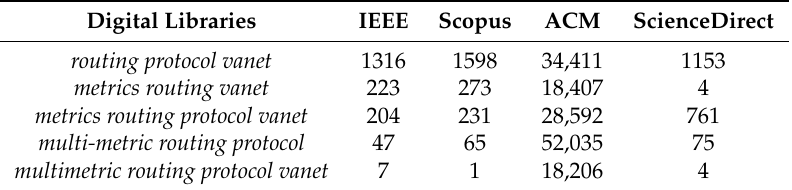
Table 1. Research results using search string.